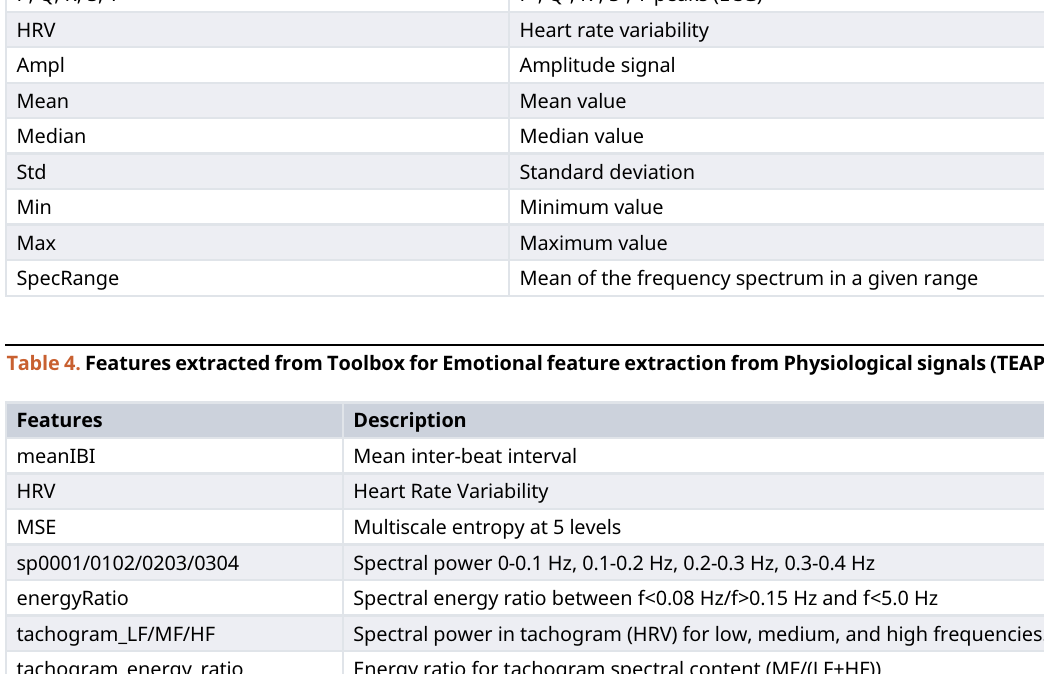
Table 3. Features extracted from Augsburg Bio-signal Toolbox (AUBT). Features